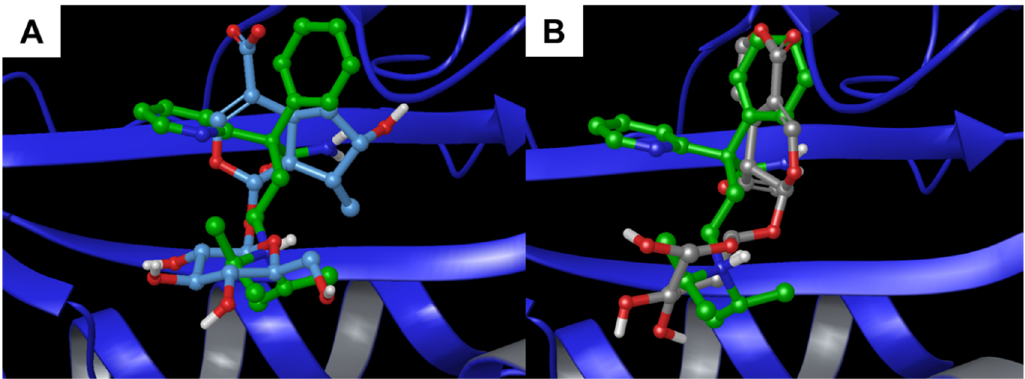
Figure 8. Superimposition between the co-crystallized prostaglandin G 2 and ( A ) 1 and ( B ) 2 inside the binding pocket of with alpha-1-acid glycoprotein (PDB: 3APW [47], blue ribbons).